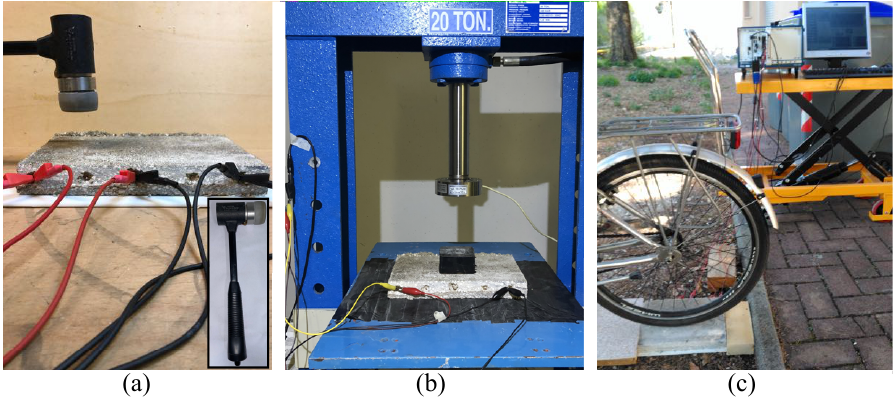
Figure 4. Loading methods: ( a ) the LL case—impact hammer; ( b ) the LM case—hydraulic press; and ( c ) the WF case—rolling